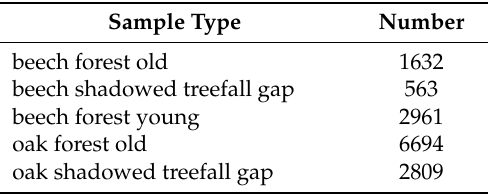
Table 2. Types and number of sampling positions for endmembers.